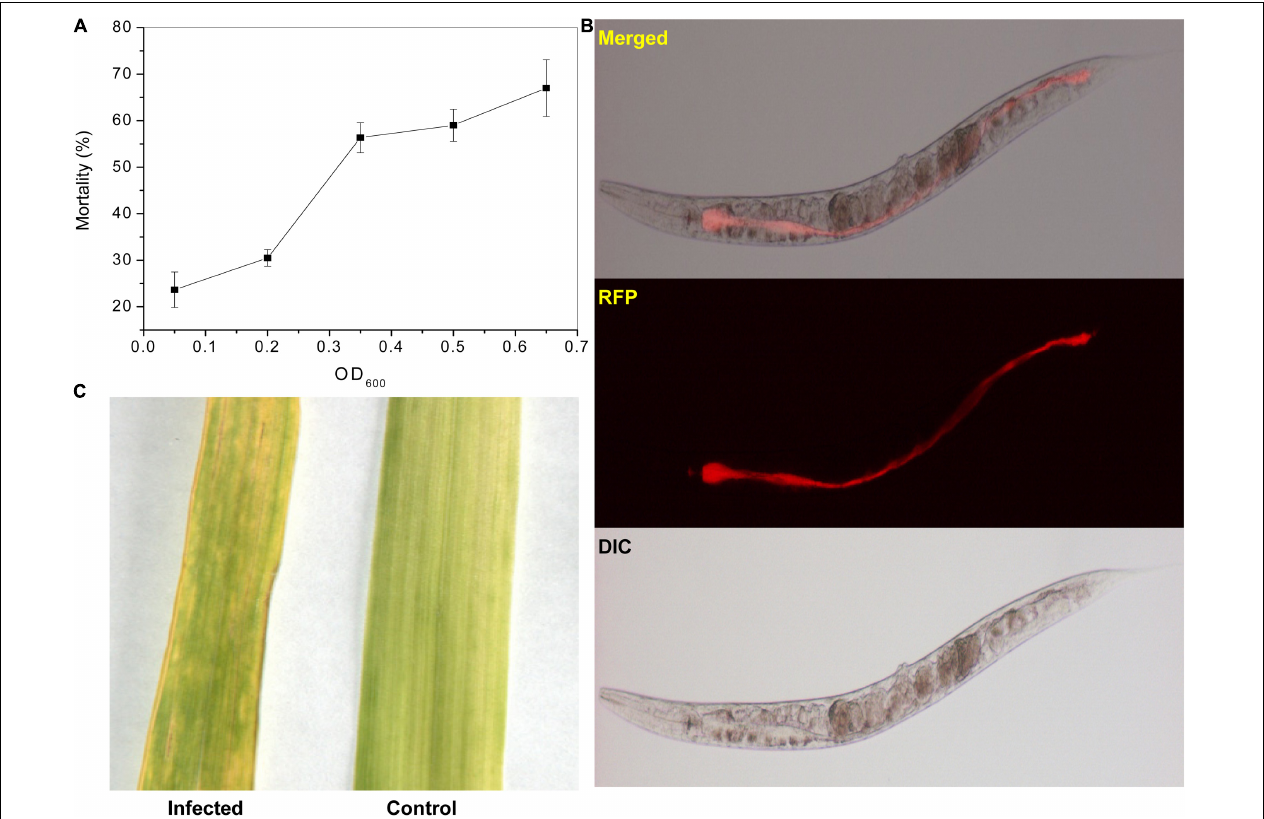
FIGURE 1 | Pathogenicity of P. syringae MB03 against C. elegans and wheat leaves. The impact of the initial cell density of MB03 on killing C. elegans is shown in figure. (A) Assay was performed in a 96 well plate. L4 synchronized worms (30–40) were placed in each assay well. The fraction of dead worms was determined after 72 h. The worms were considered dead if no response was shown to touch. Figure shows increase in worm mortality with an increase in initial cell density of P. syringae MB03. (B) Gut colonization of C. elegans by P. syringae MB03 is shown. The red fluorescence protein (RFP) expressing vector was cloned into P. syringae MB03. The worms were fed on RFP expressing P. syringae MB03 and worms were investigated after 48 h to observe distention of anterior and posterior parts of the gut. The red fluorescence is depicting colonization of the host gut by bacterial cells of P. syringae MB03 harboring pMCh-23 plasmid. (C) Infection of